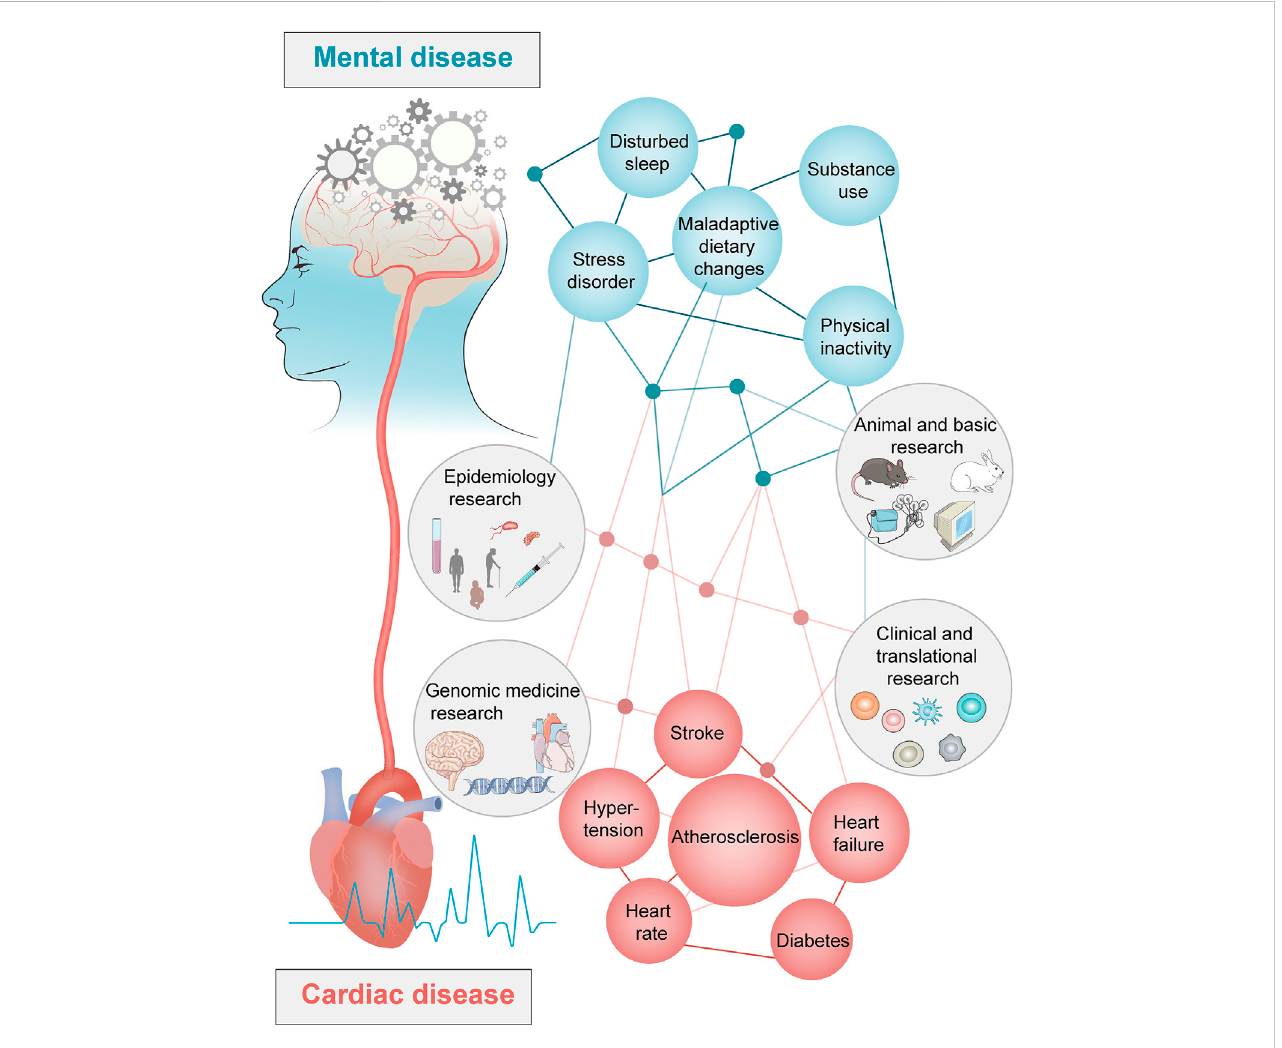
Interaction between mental diseases and cardiac